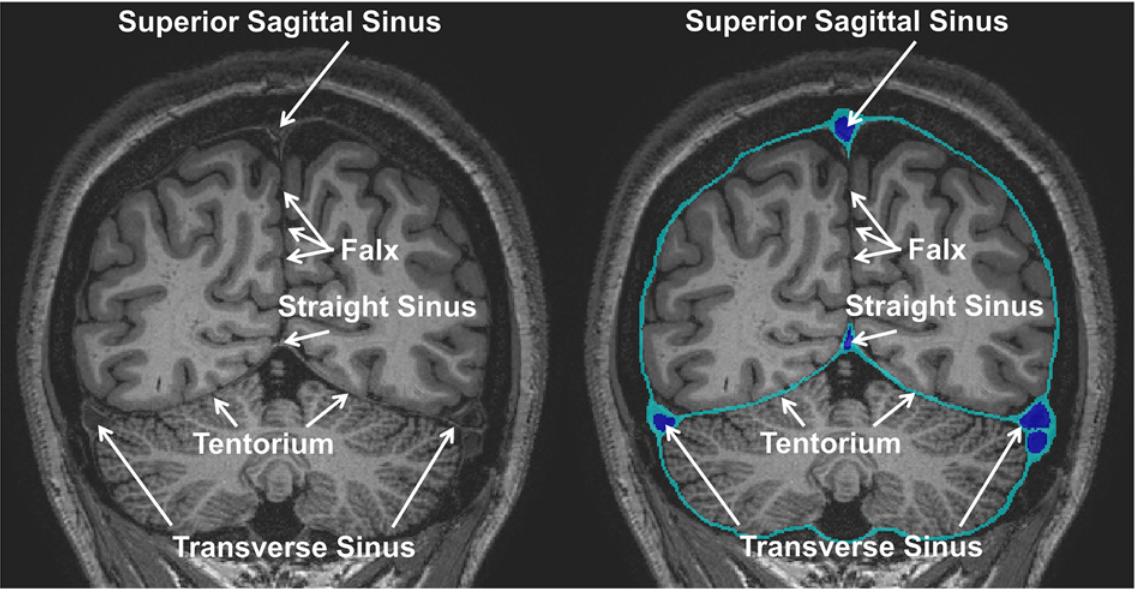
Fig 10. Segmentation of the dura mater. Coronal T1-weighted MRI (left) and outlines of the dura mater (right) with the principal dural reflections and sinuses. The falx cerebri, which separates the two cerebral hemispheres, was only partially visible on the images and was not segmented. The tentorium cerebelli was manually segmented. The superior sagittal sinus, transverse sinuses, and straight sinus — found along the attached edge of the falx, the line of attachment of the tentorium, and the line of attachment of the falx to the tentorium, respectively — were modeled as 500 μ m thick outer layers enveloping the large venous vessels visible in the MRA dataset.